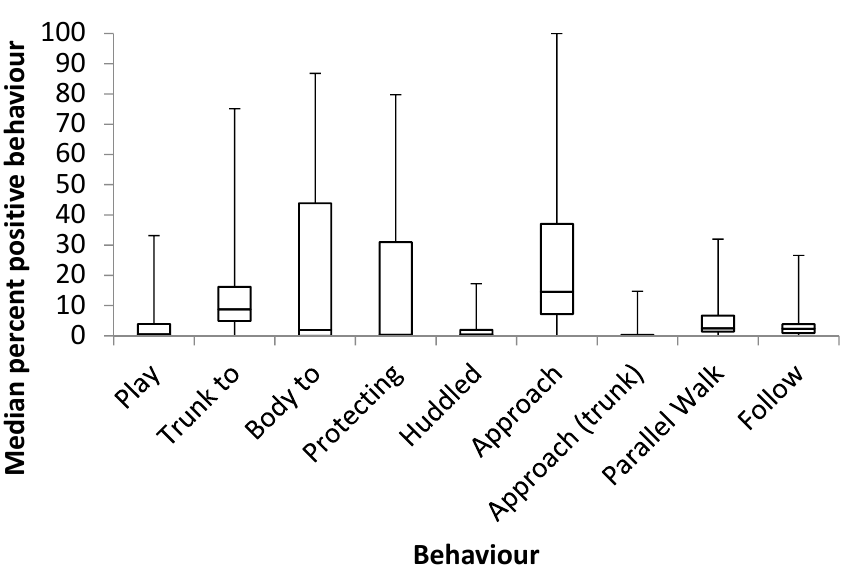
Figure 1. A breakdown of positive interactions observed. Conspecific play, trunk to- and body to- were grouped as physical interactions.